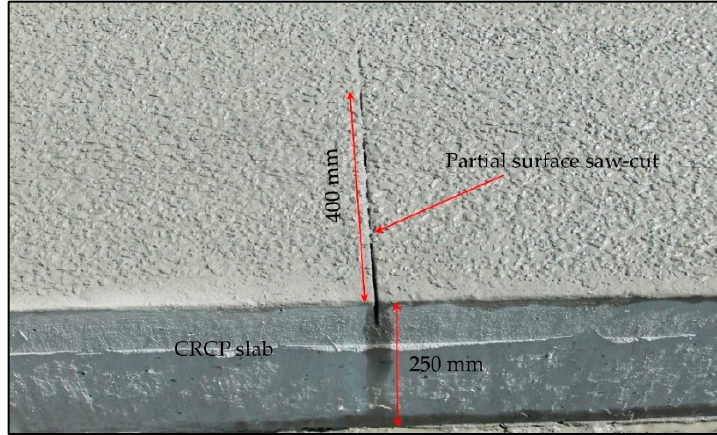
Figure 4. Partial surface saw-cut at the outer edge of the concrete slab.